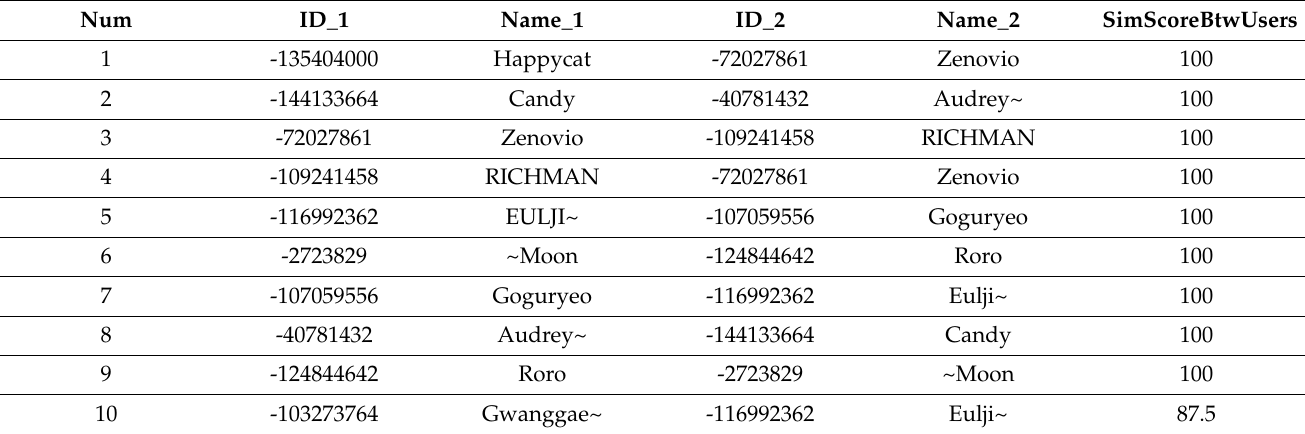
Figure 7. Similarity score between users. Table 6 lists users with scores higher than 80. Table 6. Top 10 users by similarity score. Table 6. Top 10 users by similarity score.